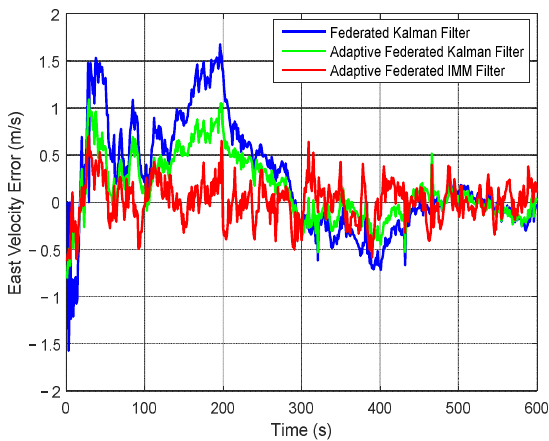
Figure 14. The estimation curves of east velocity error.